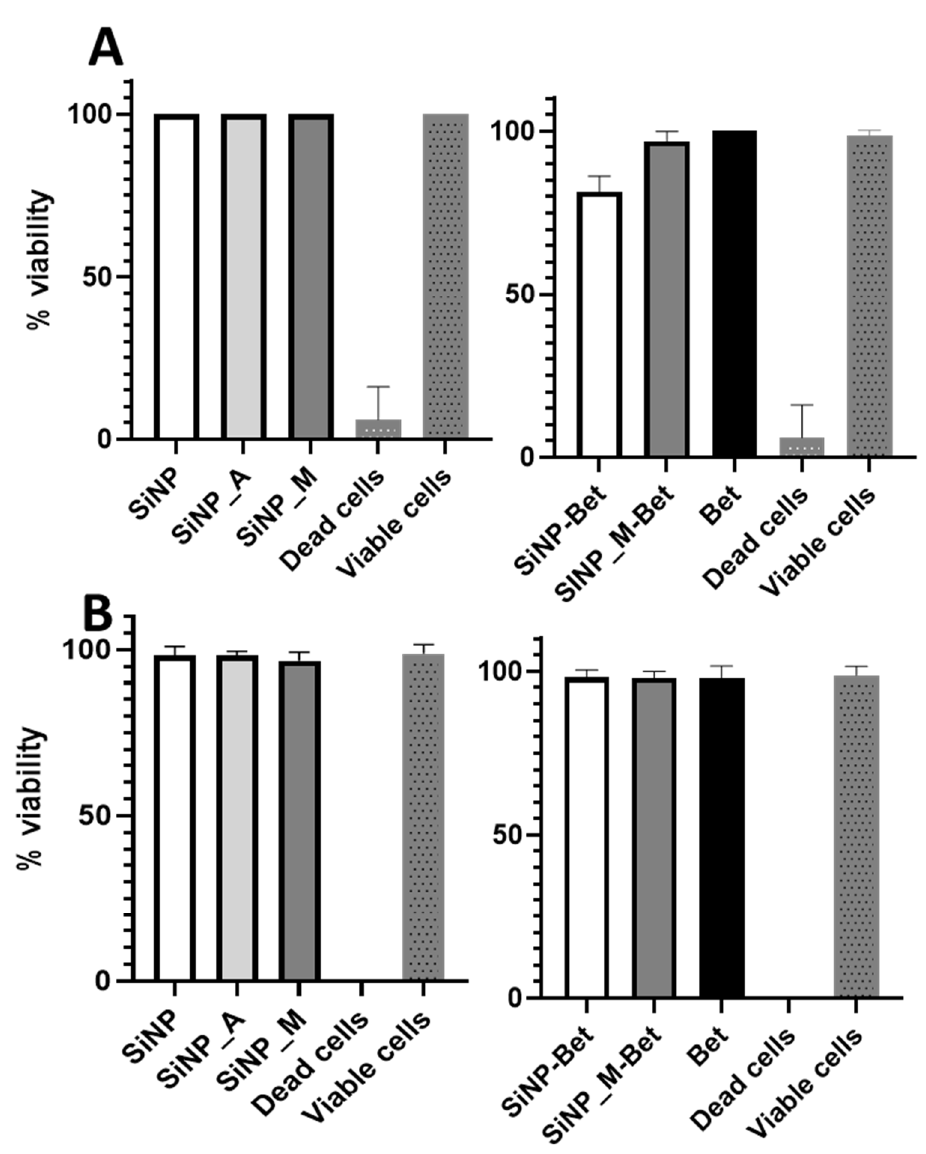
Figure 4. Viability of the moDCs tested with ( A ) LDH assay based on the release of LDH and ( B ) Live/dead staining via flow cytometry after stimulation of moDCs with the samples after 24 h. The negative control in the experiment was dead cells (incubated at 95 °C for 10 min) and the positive control (viable cells) was unstimulated moDCs.